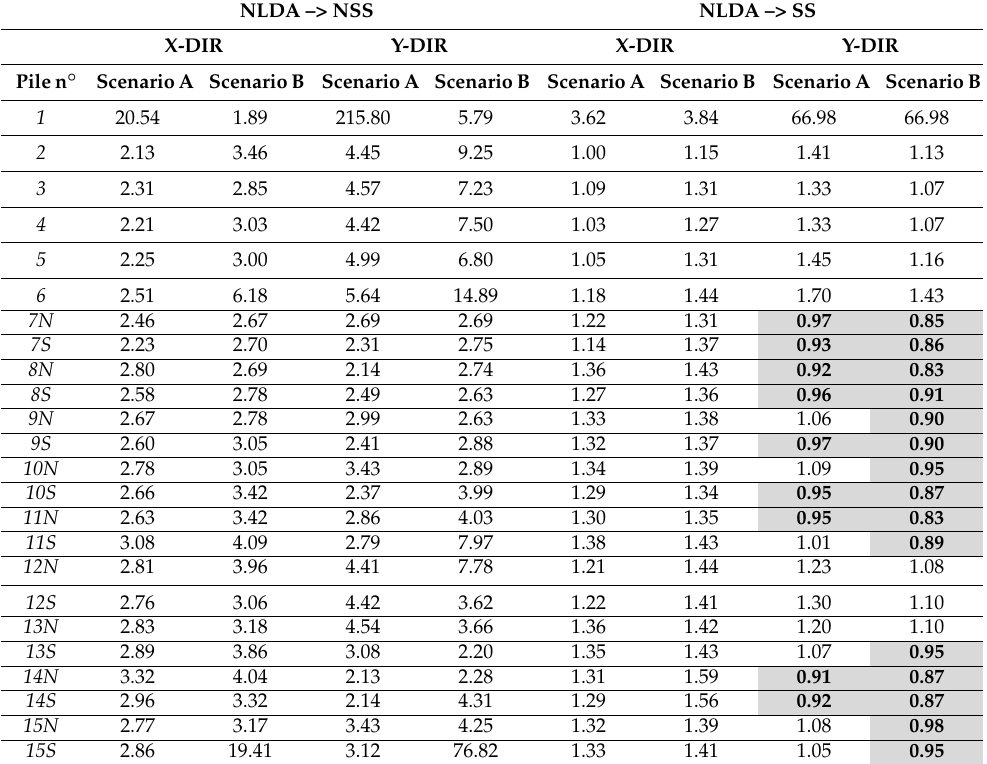
Table 9. Piles check (safety factors). Nonlinear dynamic analysis (NLDA) combined with non-site- specific (NSS) and site-specific (SS) approaches. Safety conditions were satisfied for all piles with regards to NSS approach. Unsatisfied verifications are in bold and worst condition is underlined in SS approach. NLDA –> NSS NLDA –> SS X-DIR